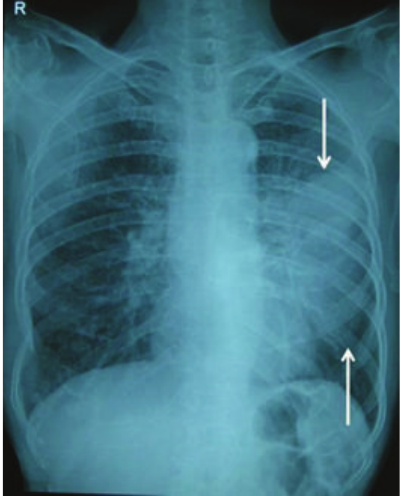
Figure3:Chestradiographrevealedahomogeneousopacityinvolv- ing the entire mid- and lower zones of the left